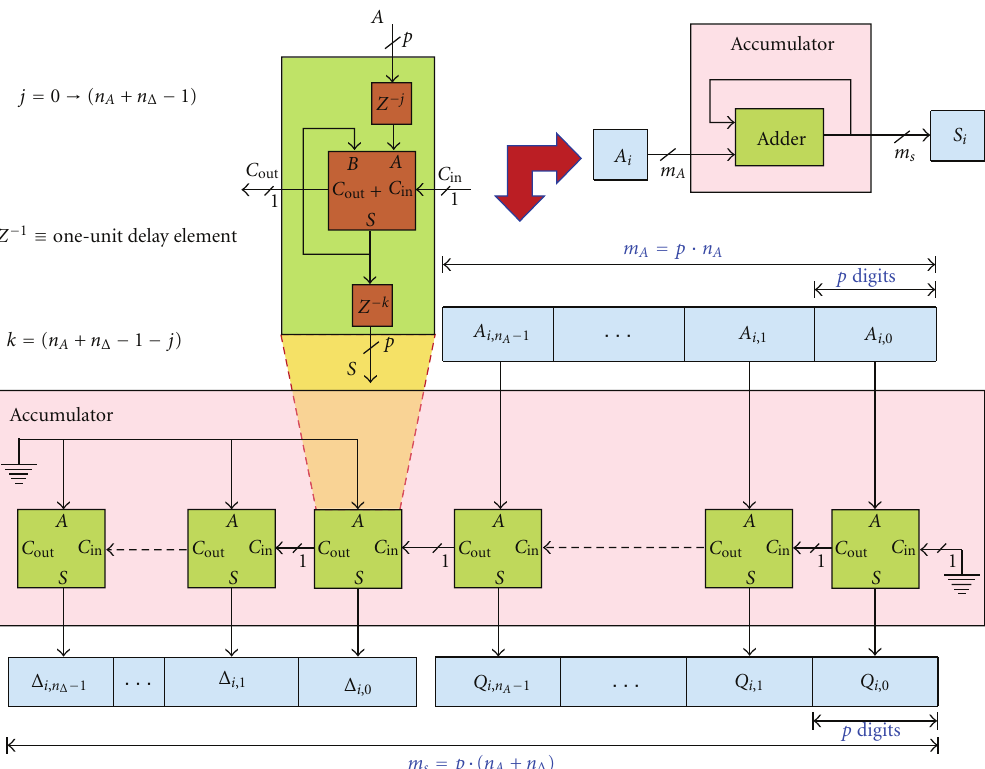
Figure 8: Generalized nonlinear-pipelined accumulator.